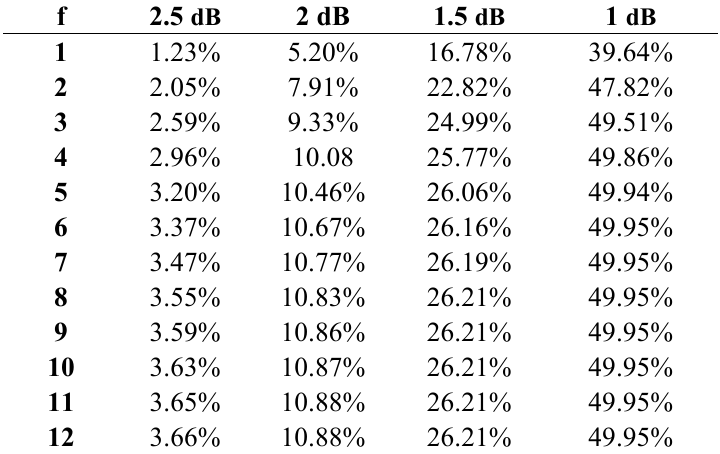
Table 4. Application layer packet error rate. These values refer to a single or fragmented packet that occupies the entire space of a 802.15.4 frame. The value for f = 1 refers to a single non-fragmented packet. A packet can consist of a maximum of 12